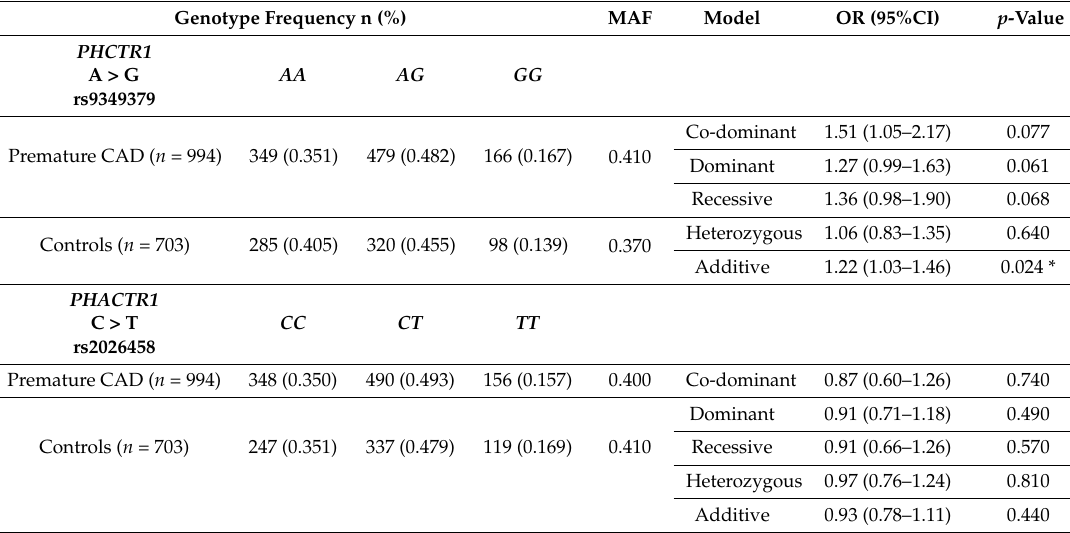
Table 2. Association of the PHACTR1 polymorphisms with premature